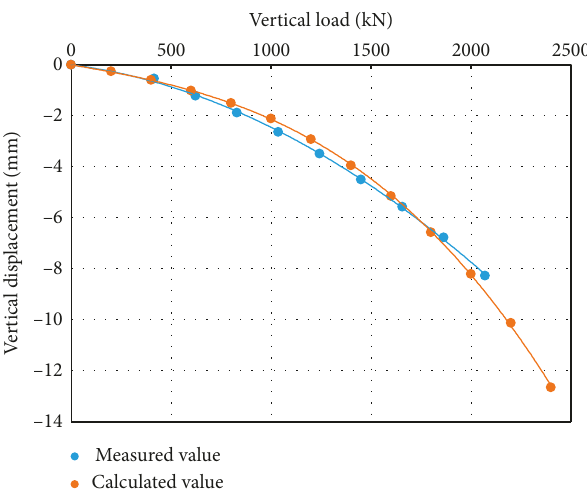
Figure 8: Relationship curve for vertical load and displacement.